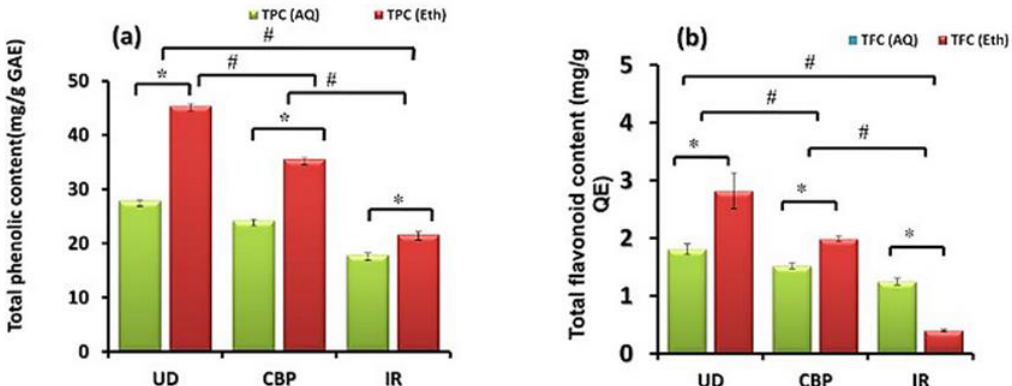
Figure 3. Comparative total phenolic ( a ) and flavonoid ( b ) contents of aqueous (AQ) and ethanolic (Eth) extracts of Urtica dioica (UD), Capsella bursa-pastoris (CBP), and Inula racemosa (IR). Data are shown as the mean ± SD for n = 3. * (intragroup) and # (intergroup) p < 0.05 were considered statistically significant.